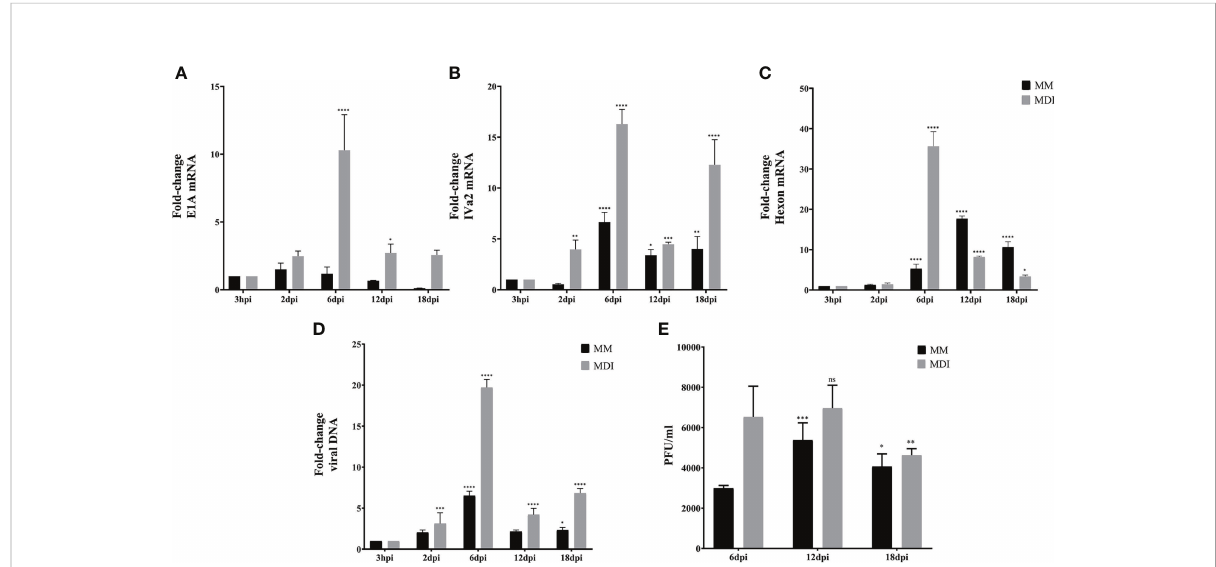
FIGURE 6 Adipocyte commitment of 3T3-L1 cells is required to support productive replication of HAdV-D36. 3T3 cells treated with or without adipocyte differentiation inducers (MDI or MM) were infected 12dpc, and RNA and DNA were puri fi ed as described in materials and methods. Expression levels of E1A (A) , IVa2 (B) and Hexon (C) were measured by RT-qPCR and DNA by qPCR (D) . Viral progeny production was determined by plaque assay (E) . Primers were designed to hybridize at exon-exon junctions to measure mature mRNA and at sequences that correspond to intron-exon junctions to measure DNA. All values represent the mean of two independent experiments, measured in technical duplicates. Data are expressed as the mean and error bars represent standard deviations. Signi fi cant differences from each time-point relative to 3h (A-D) and relative to 6 dpi (E) are indicated by *p < 0,05. **p < 0,005. ***p < 0,0005. ****p < 0,00001. ns, not signi fi cant.